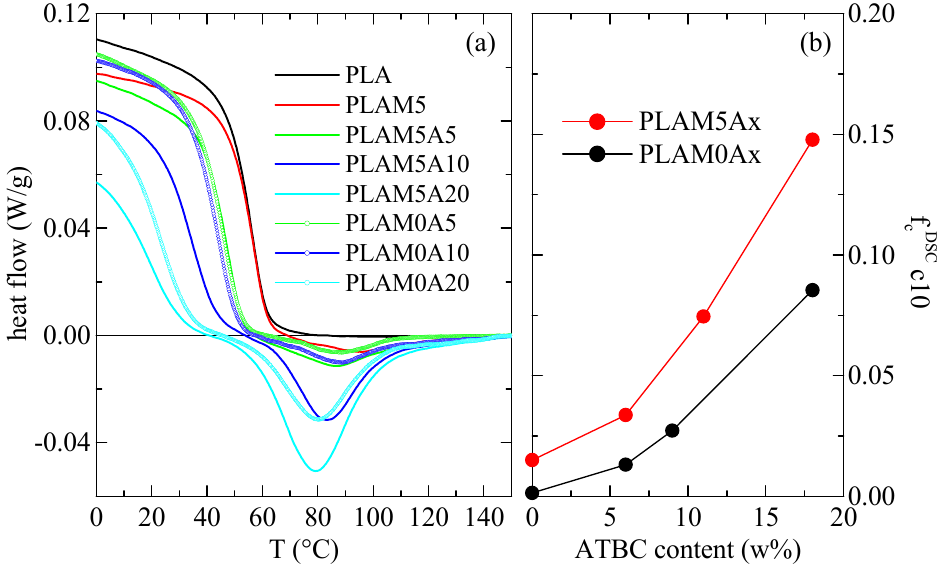
Figure 5. DSC cooling curves (exo down) at 10 °C/min of: ( a ) the different samples and ( b ) DSC crystallinity on cooling at that rate as function of the ATBC content in the sample.